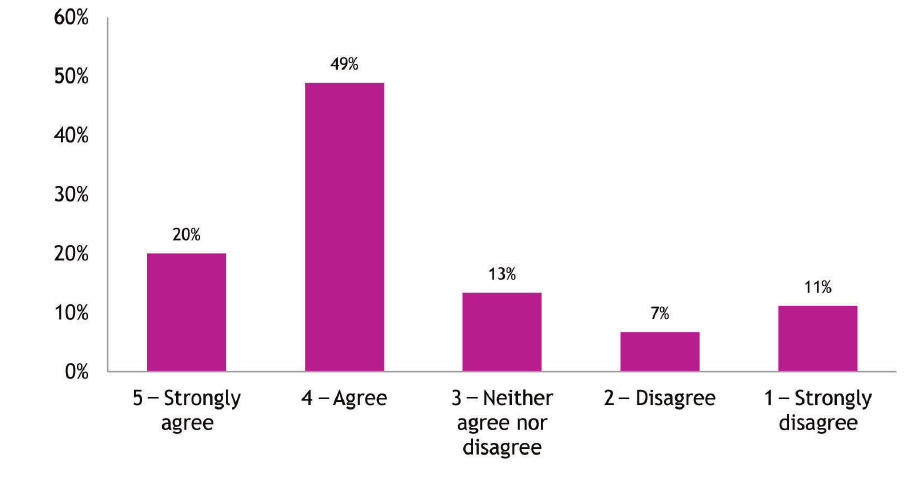
Figure 2: Chart showing audience response to the statement ‘Tactile Collider has inspired me to learn more about